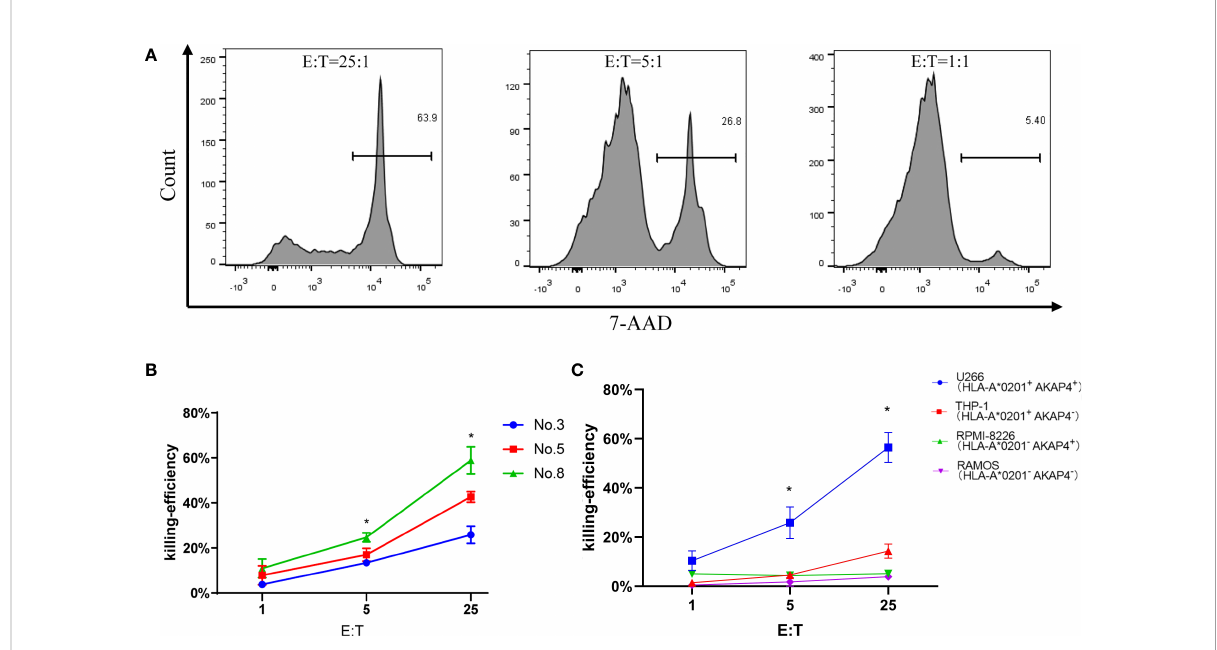
FIGURE 4 Tumor cell line killing assay shows the anti-myeloma effect of peptide No. 8 speci fi c CTLs in vitro. (A) The killing ef fi ciency of CTL stimulated by No. 8 antigen peptide on U266 cell line under different effect target ratio (the effective target ratio is 25 in the left fi gure, 5 in the middle fi gure, and 1 in the right fi gure). (B) Compared to CTLs induced by peptide No. 5 and No. 3, peptide No. 8 speci fi c CTLs lyse U266 cell more ef fi ciently. (C) Peptide No. 8 speci fi c CTLs lyse HLA-A*0201 + AKAP4 + myeloma cell line U266, while the other HLA-A*0201 - or AKAP4 - cell line is not